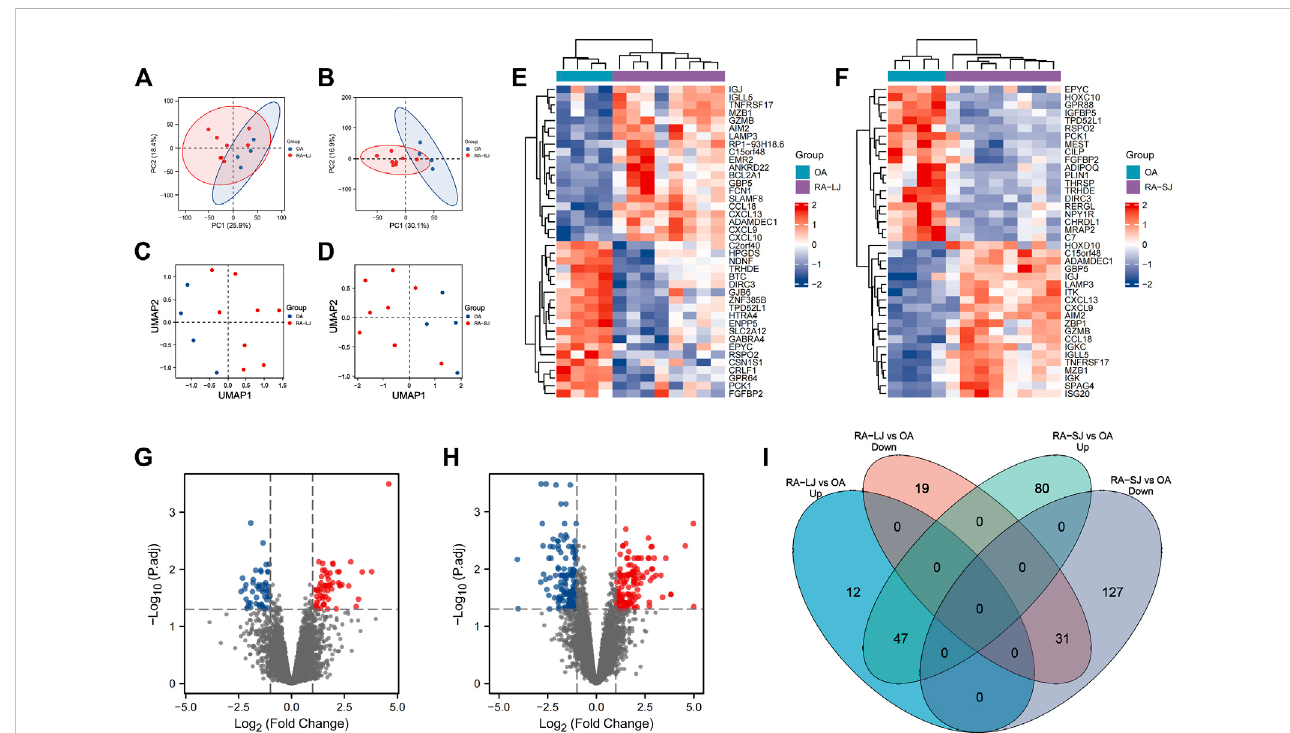
FIGURE 1 DEGs were identi fi ed from the online GEO dataset. (A) – (D) RA-LJ and RA-SJ samples are separated from OA samples in PCA and UMAP analyses. (E) (F) Heatmaps showed the top 20 upregulated and downregulated genes between RA and OA. (G) (H) Genes in RA samples and OA samples were signi fi cantly separatedinthevolcanoplot.Redrepresentsupregulatedgenes,andbluerepresentsdownregulatedgenes (I) Venndiagramofdifferentiallyexpressedgenes between RA-LJ and RA-SJ samples compared with OA